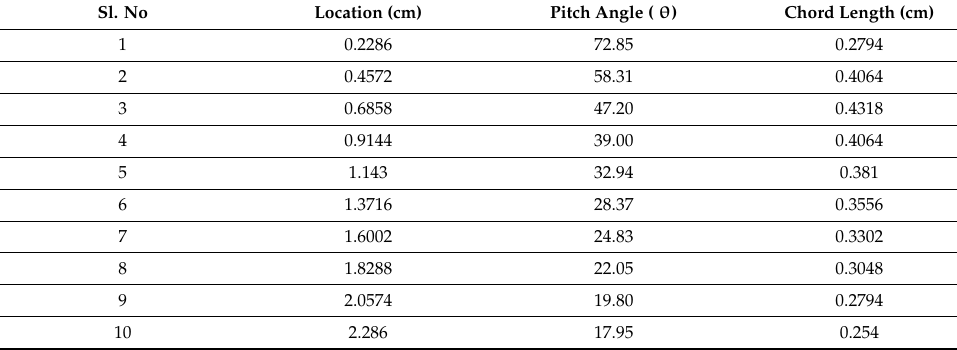
Table 8. Calculated design data of four blade